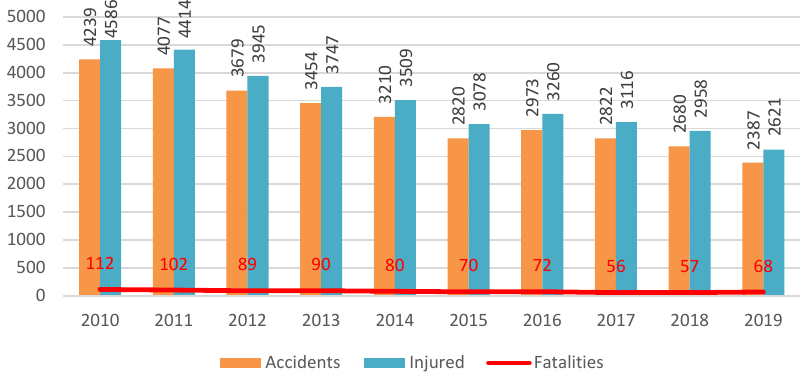
Figure 1. Road accidents involving children aged 0 – 14 in 2010 – 2019 in Poland.